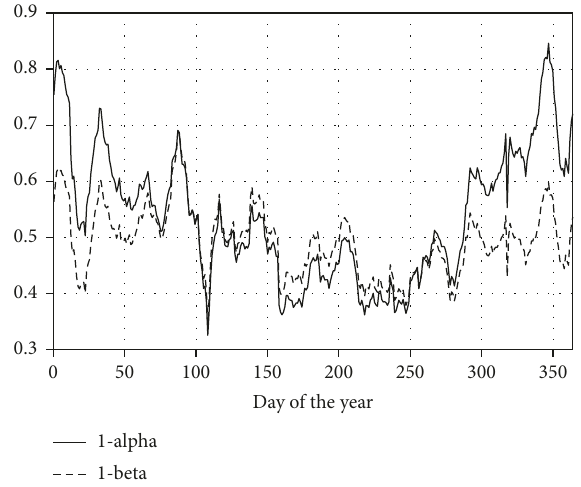
Figure 1: β fluctuates around a fixed value by large values of α obtained in